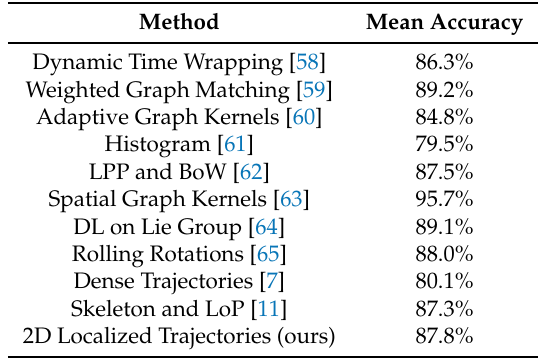
Table 2. Mean accuracy of recognition (%) on G3D dataset for Dense Trajectories and 2D Localized Trajectories approaches against literature.